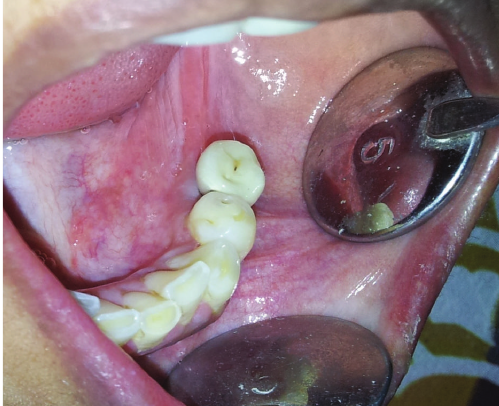
Figure 4: Fixed ceramometal prosthesis is placed (occlusal